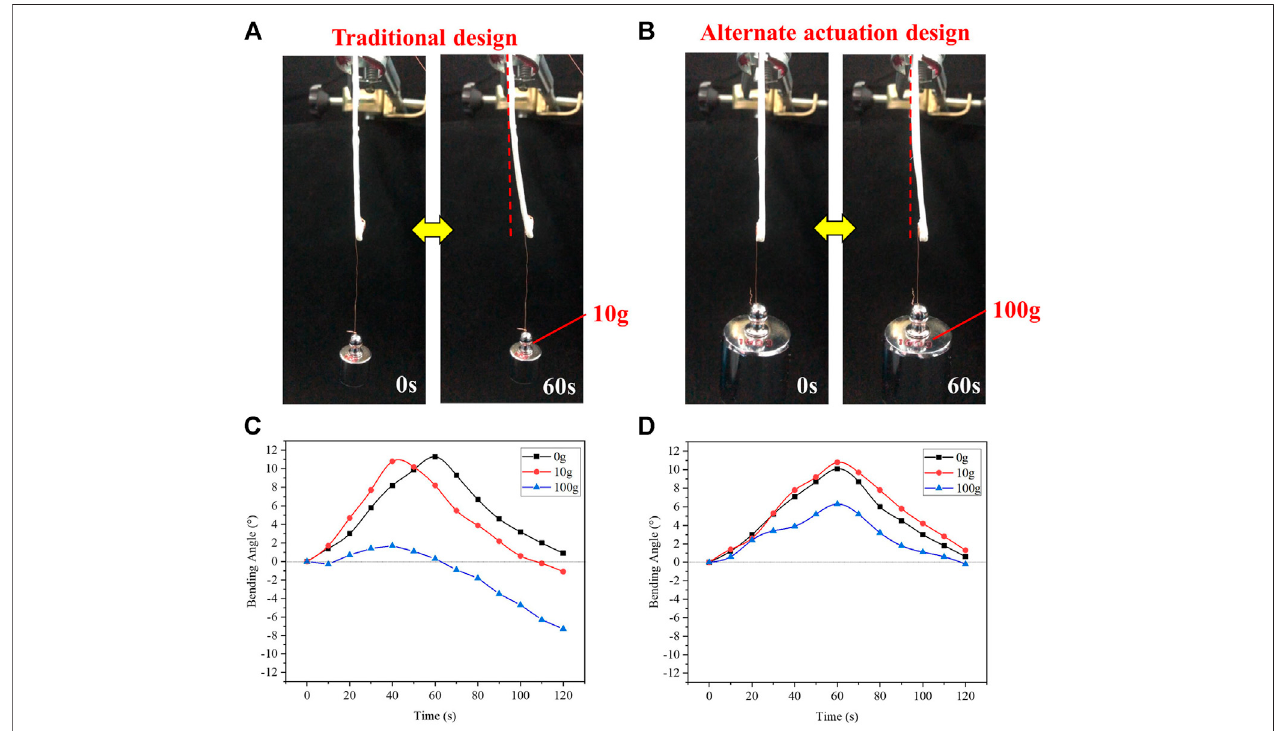
FIGURE 6 | Comparison of deformation under load of traditional design and alternate-actuation design. (A) Traditional structure deformed under 10 g load. (B) Alternate-actuated structure deformed under 100 g load. (C) Bending angle as a function of time for traditional structure under different continuous loads. (D) Bending angle as a function of time for alternate-actuated structure under continuous loads.